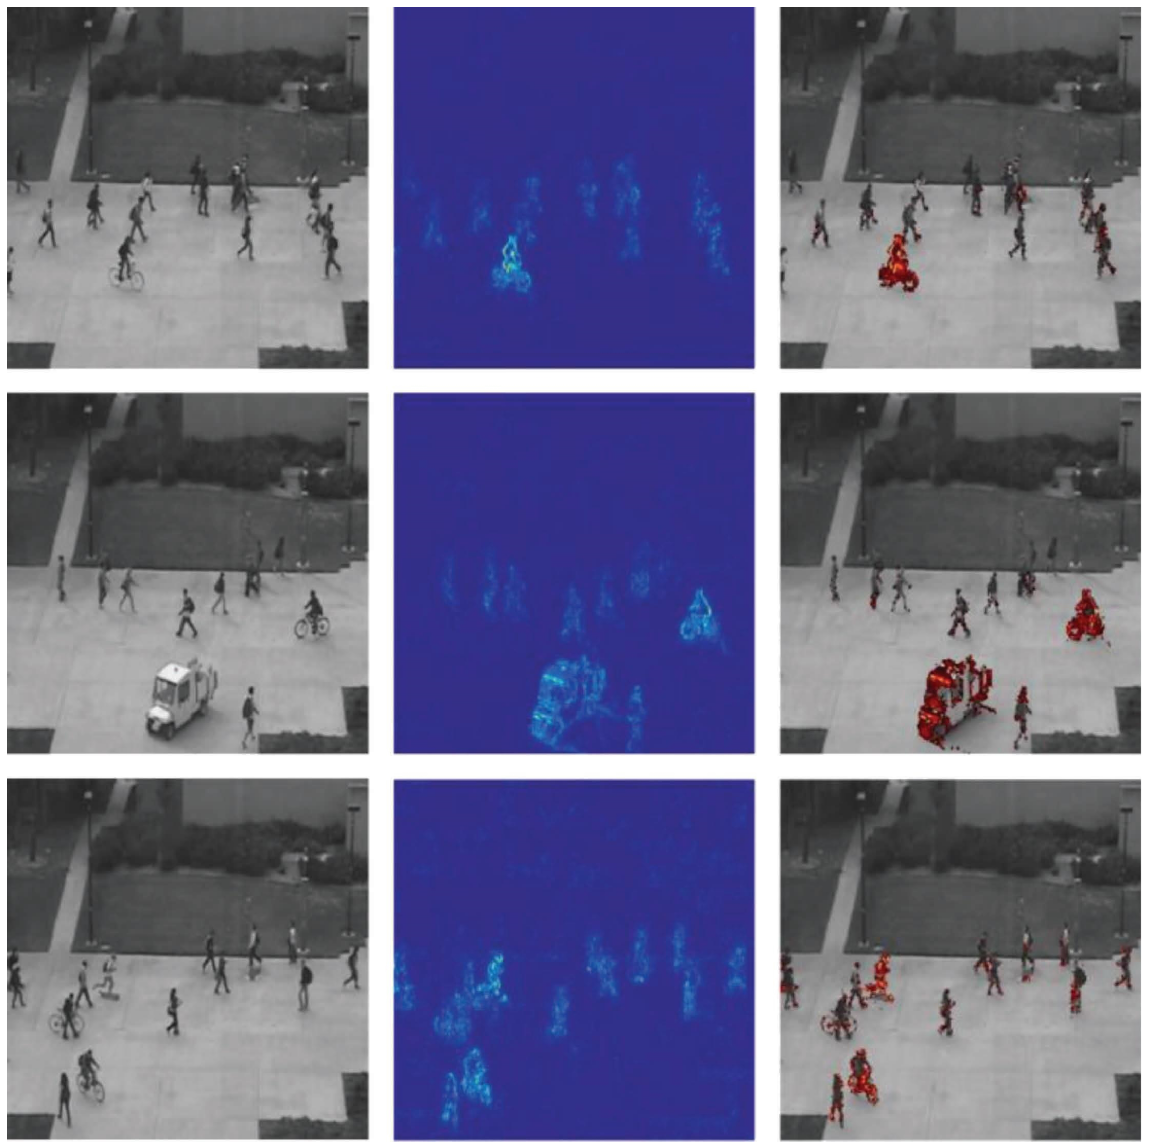
Figure 14: Visualization results of the Ped2